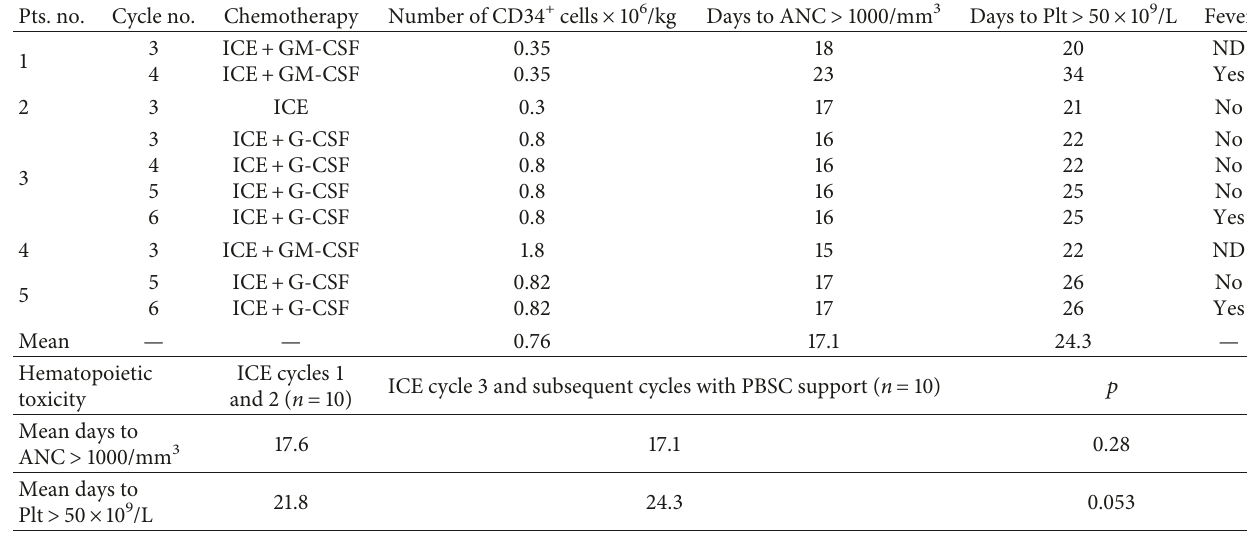
Table 1: PBSC support and hematopoietic recovery after postinduction cycles of ICE; comparison of induction and postinduction cycles. Pts. no. Cycle